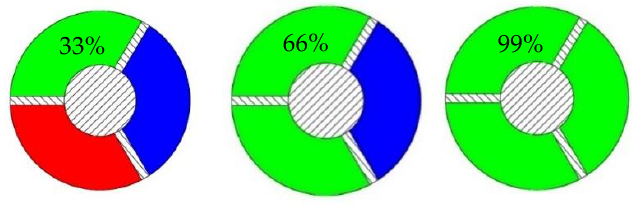
Figure 7. Percentage of filament colouring with the proposed device.